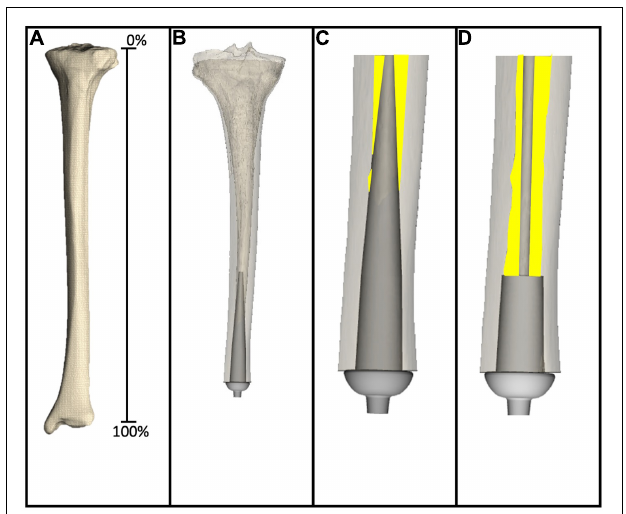
FIGURE 2 | (A) Virtual tibia created from reconstructing CT scans to generate 3D computer model. (B) 3D computer model amputated to 80% residual length, and virtually implanted with a large diameter stemmed endoprosthesis. (C) Magnified image of the large diameter stemmed endoprosthesis virtually implanted into the virtual tibia, showing only the medullary canal analyzed in this study. Yellow highlights the remaining medullary canal available following virtual implantation. (D) Magnified image of the small diameter stemmed endoprosthesis virtually implanted into the virtual tibia. Yellow highlights the remaining medullary canal available following virtual